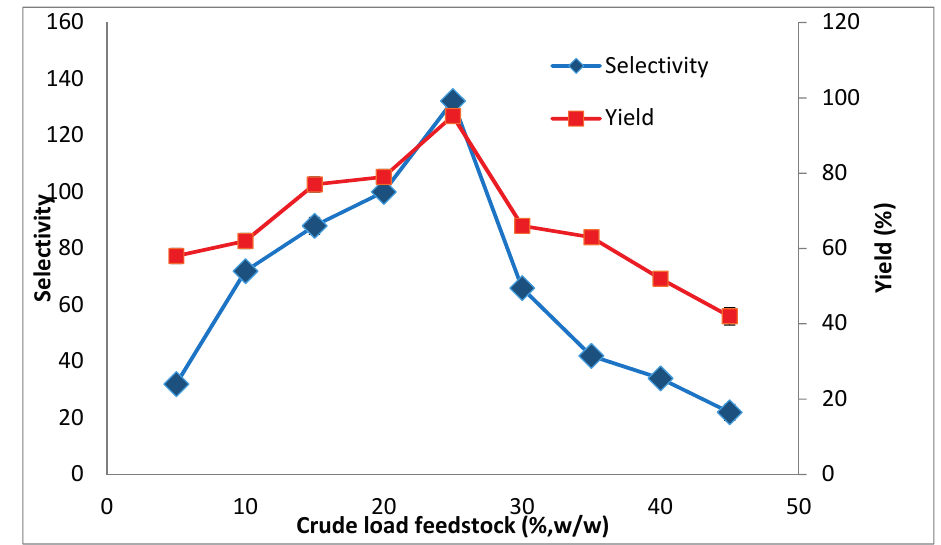
Figure 3. Influence of crude load on the partitioning of lipase. The selectivity ( ♦ ) and yield ( ■ ) were calculated as a function of the crude load, according to Equations (2) and (6), respectively. The results were expressed as the mean of triplicate readings, which have an estimated error of